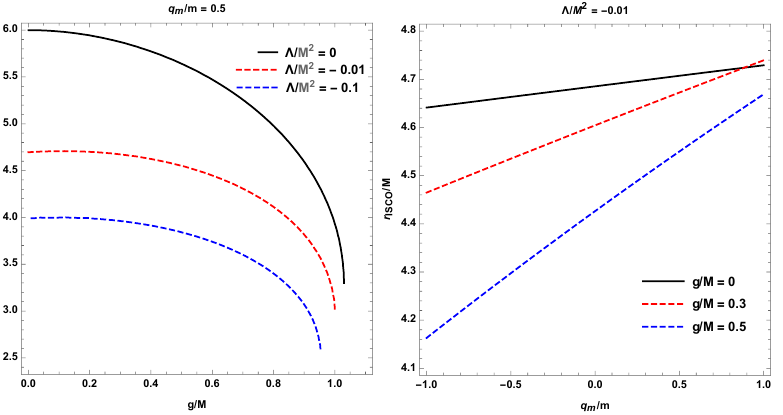
Figure 10. The correspondence between the ISCO radius of the magnetically charged test particle and parameters g , Λ , and q m .